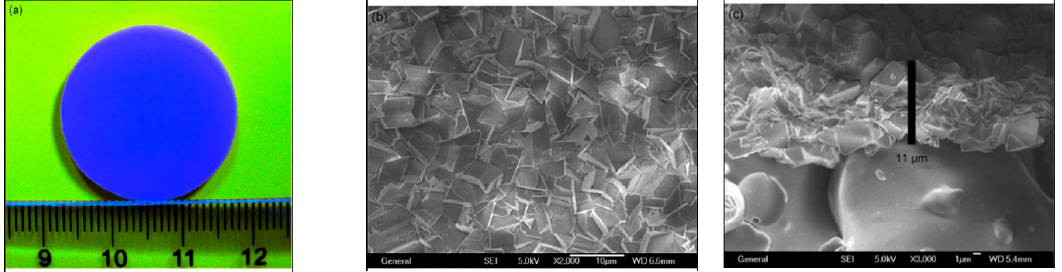
Figure 47. ( a ) Optical image of a CO 3 (HCOO) 6 membrane grown on a glass frit. ( b ) Top and ( c ) side view SEM images of the intergrown layer (adapted with permission from ref. [146]). Figure 48. ( a ) CO 2 /CH 4 permeance and separation factor (SF) of the Co 3 (HCOO) 6 membrane versus permeation temperature. ( b ) Plot of the CO 2 /CH4 separation factor of the Co 3 (HCOO) 6 membrane as a function of test time (adapted with permission from ref. [146]).